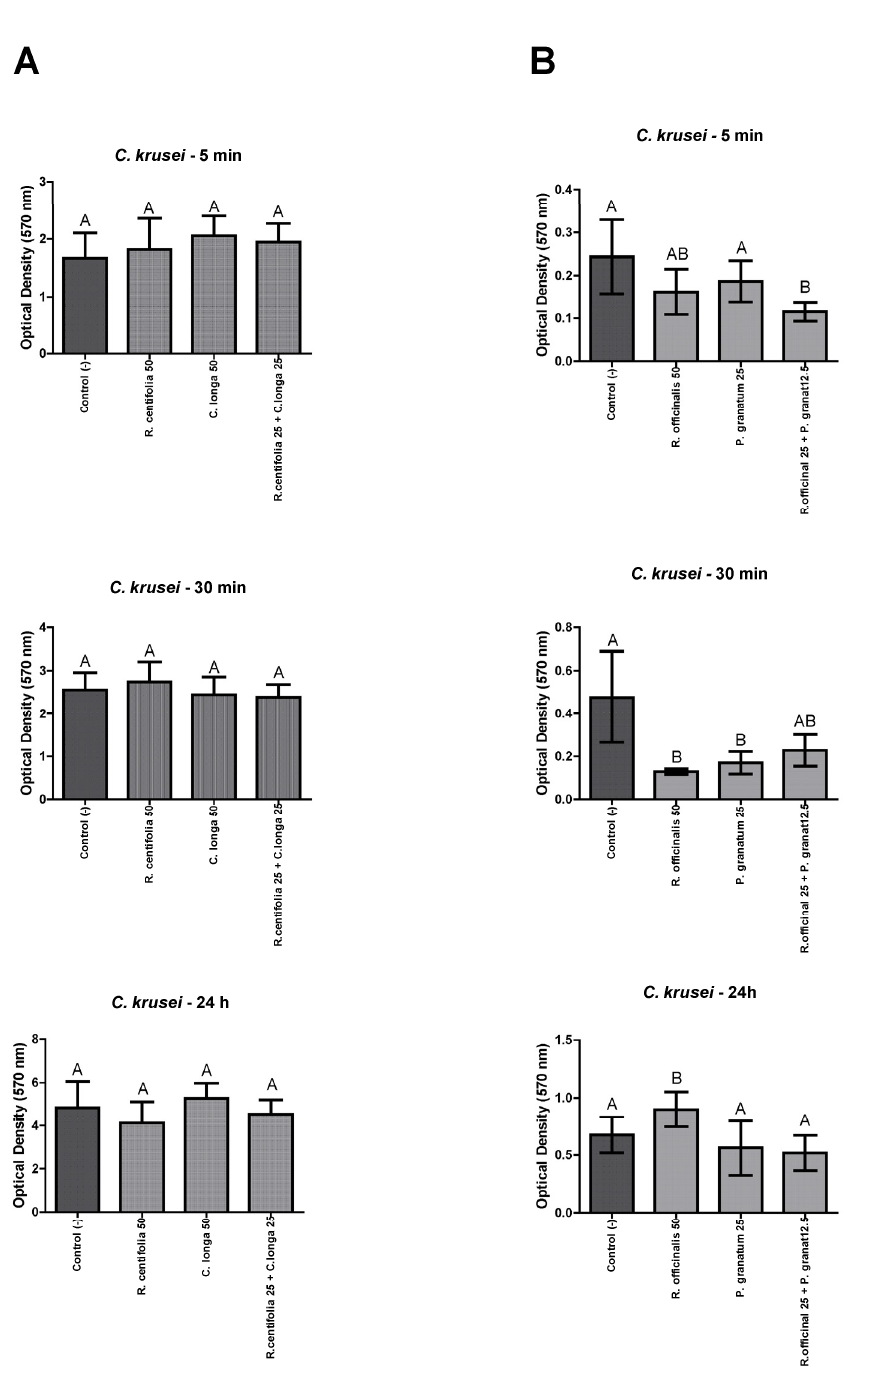
Figure 4. C. krusei biofilm load reduction after treatment with R. centifolia , C. longa , R. officinalis , and P. granatum glycolic extracts, and their combinations, for 5 min, 30 min, and 24 h. Legend: Different upper-case letters indicate a statistically significant difference.